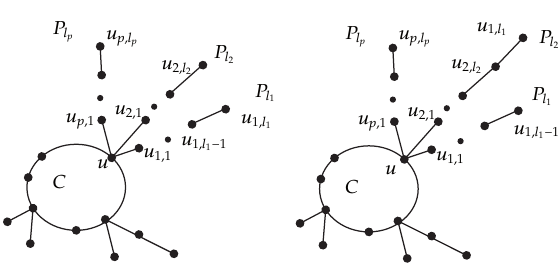
Figure 1: Example of π 1